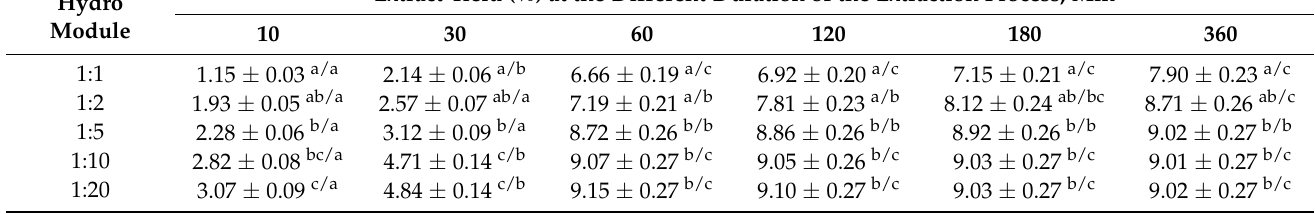
Table 1. Dependence of the yield of the Dactylorhiza maculata extract on the hydro module at different durations of the process (temperature 60 ◦ C).